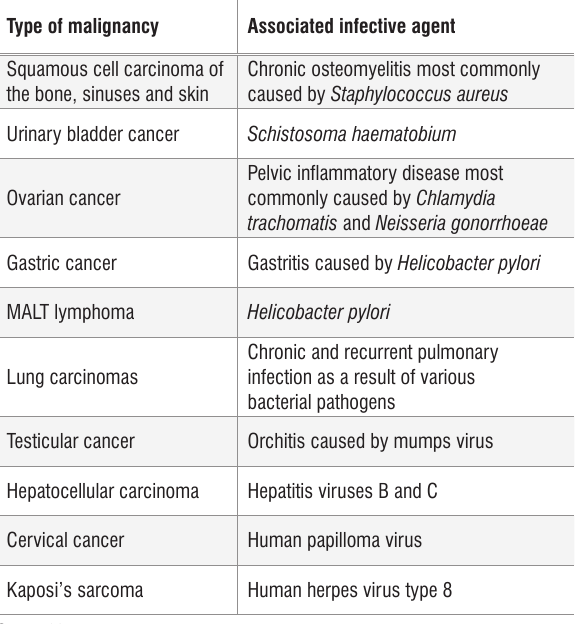
Examples of inflammation-related malignancies of chronic in- fective origin